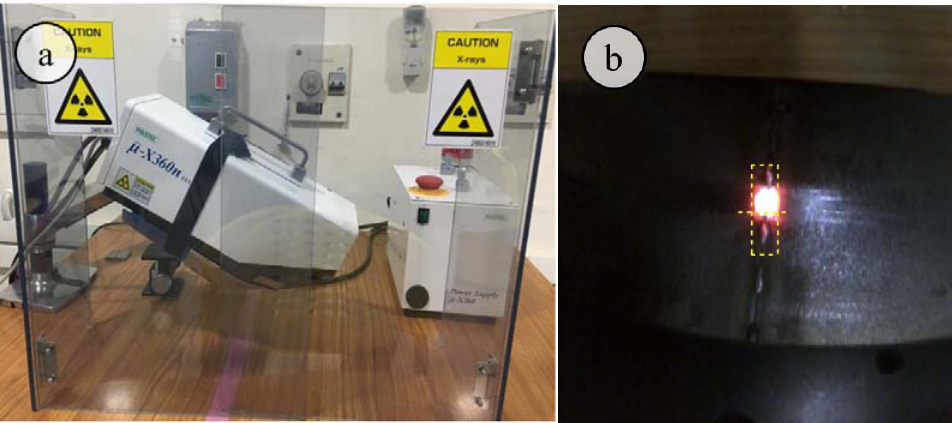
Figure 4. Residual stress measurement: ( a ) residual stress equipment, ( b ) camera image for sample location.